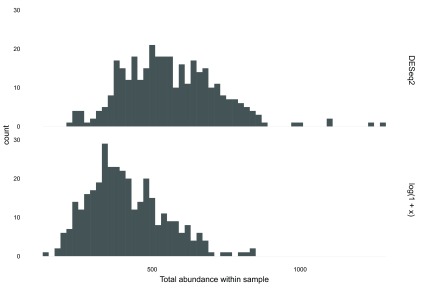
The histogram on the top gives the total DESeq2 transformed abundance within each sample.The bottom histogram is the same as that in
Figure 7, and is included to facilitate comparison.